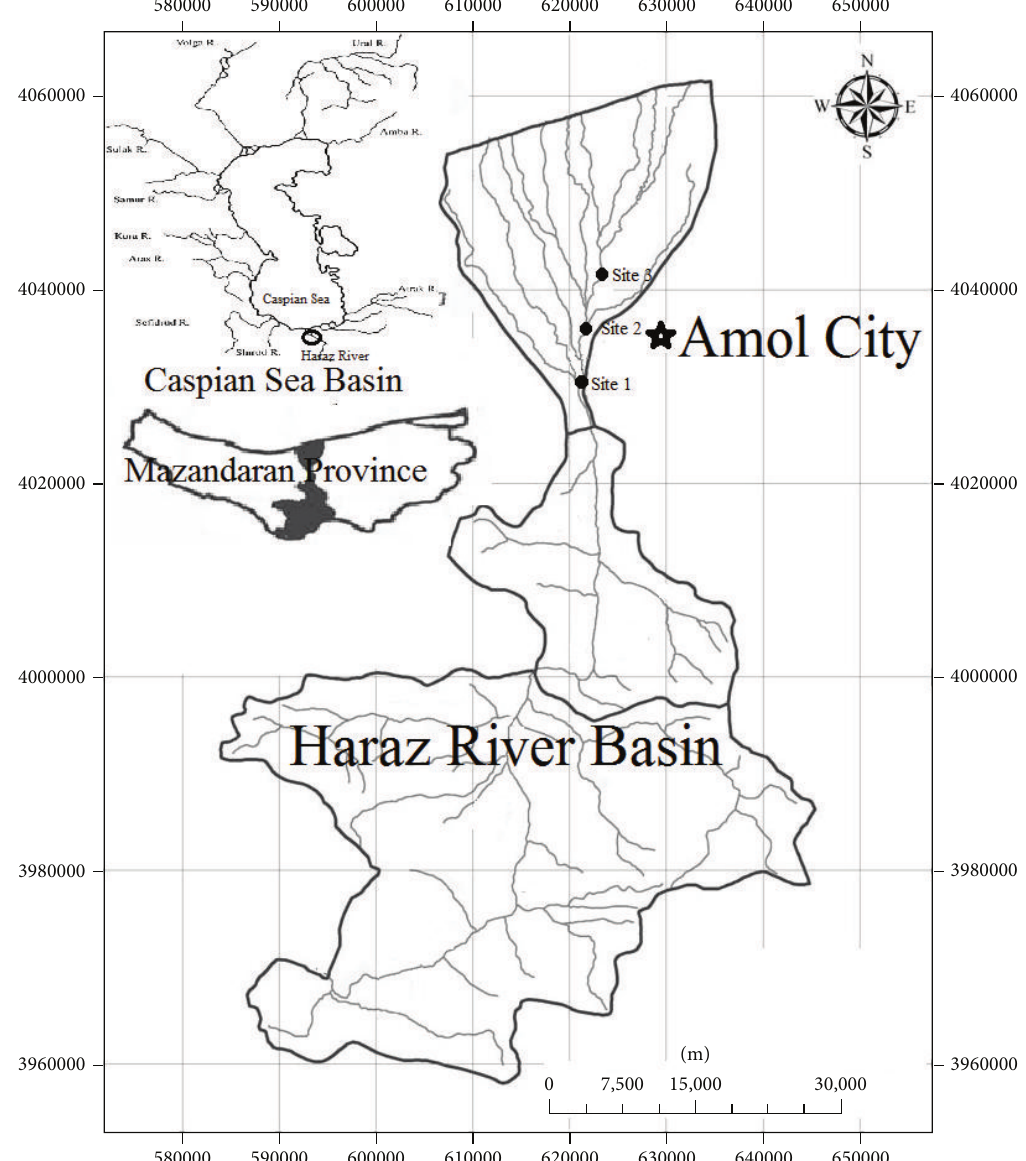
Figure 1: Location of sampling sites in the Haraz River, southern Caspian Sea